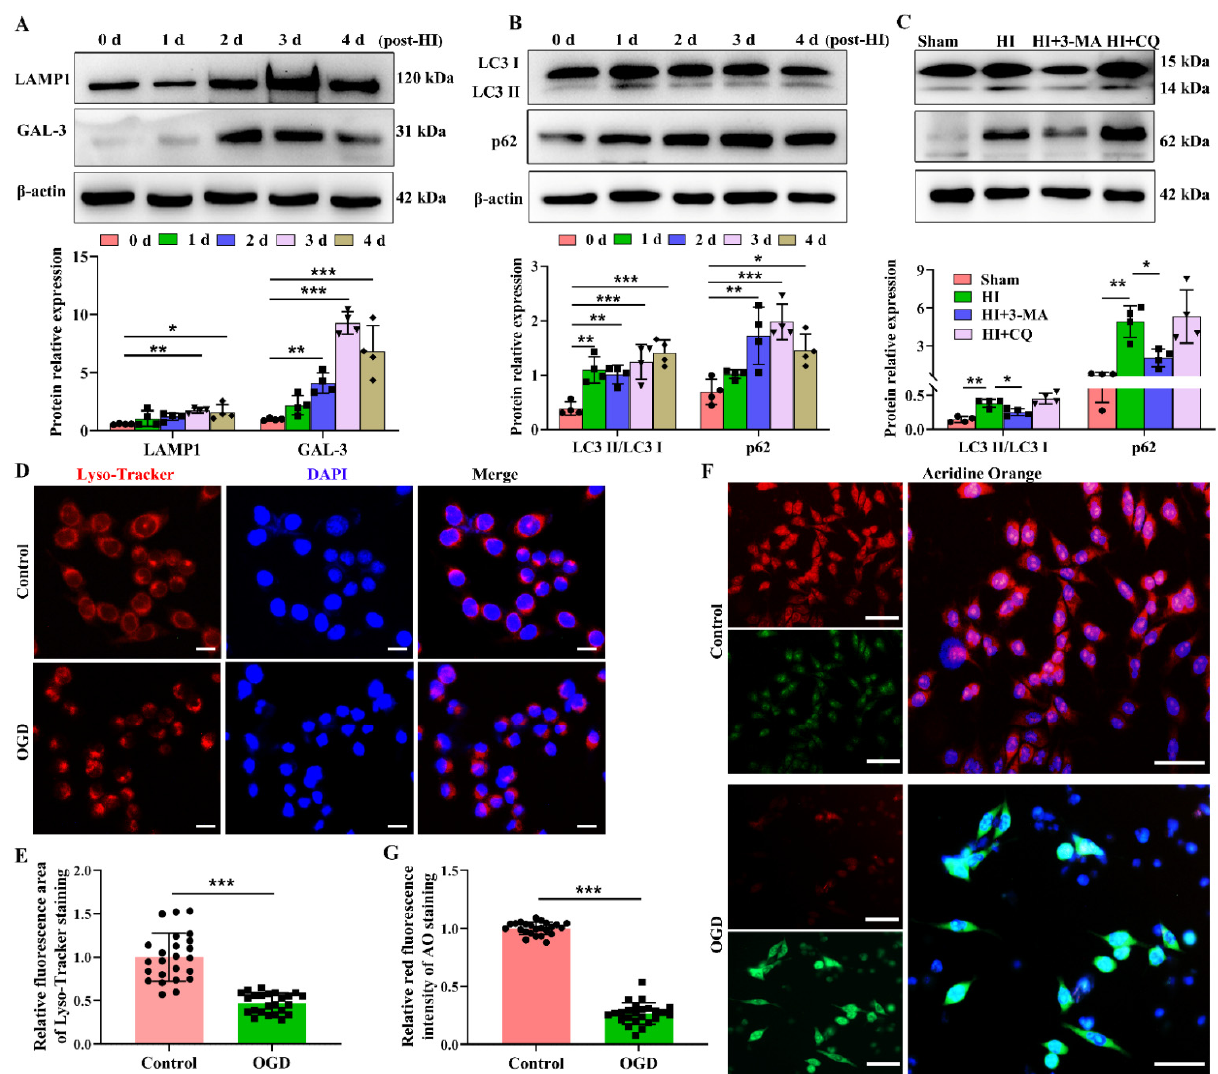
Figure 2. HI exposure led to lysosomal damage and disrupted autophagy flux. ( A ) Protein expression levels of LAMP1 and GAL-3 in the ipsilateral cortex were determined at 0 day (d), 1 d, 2 d, 3 d, and 4 d post-HI ( n = 4). All experiments were performed three times. ( B ) The levels of LC3-II and p62 in the ipsilateral cortex were determined at 0 d, 1 d, 2 d, 3 d, and 4 d post-HI ( n = 4). All experiments were performed three times. ( C ) The levels of LC3-II and p62 in the ipsilateral cortex with 3-MA or CQ treatment were determined at 3 d post-HI ( n = 4). All experiments were performed three times. ( D,E ) BV-2 cells were incubated Lyso-Tracker Red to assess lysosomal stability following OGD ( n = 6). ( F,G ) BV-2 cells were incubated with AO to evaluate lysosomal dysfunction following OGD ( n = 6). Values represent the mean ± SD, * p < 0.05, ** p < 0.01, *** p < 0.001 according to one-way ANOVA with Dunnett corrections in ( A , B ); * p < 0.05, ** p < 0.01 according to one-way ANOVA with Bonferroni corrections in ( C ). *** p < 0.001 according to t -test in ( E , G ). 3-MA, 3-methyladenin; AO, acridine orange; CQ, chloroquine; DAPI, 4 ′ ,6 ′ -diamidino-2-phenylindole dihydrochloride hydrate; GAL-3, galectin-3; HI, hypoxia–ischemia; LAMP1, lysosomal-associated membrane protein 1; LC3, microtubule-associated protein 1 light chain 3; OGD, oxygen–glucose deprivation.